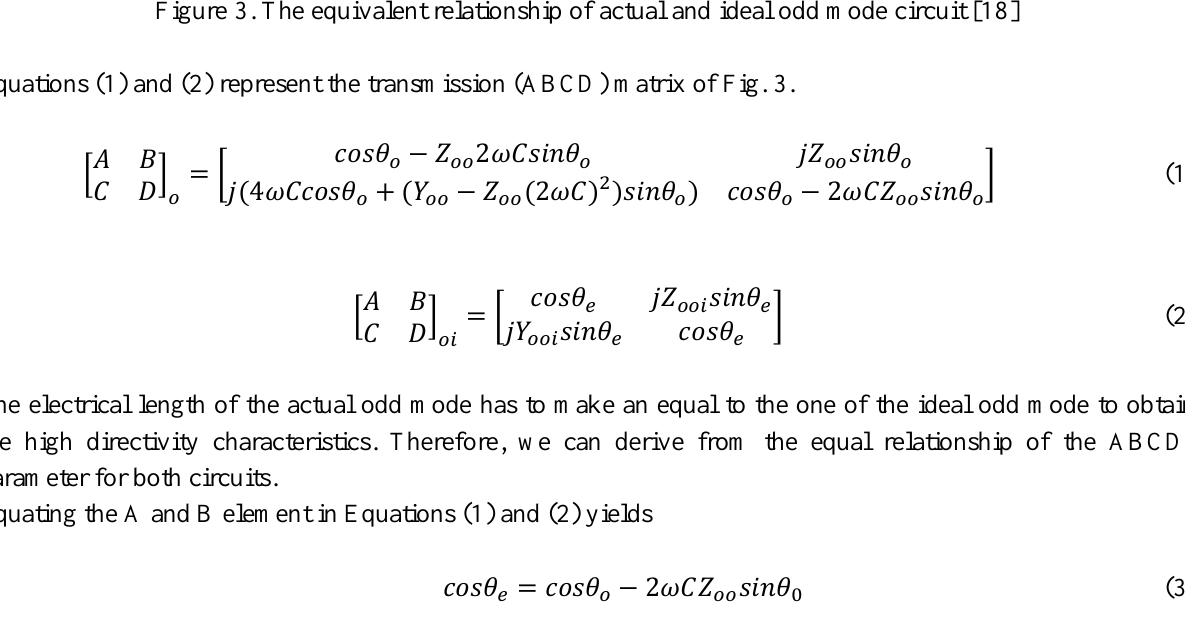
Figure 3. The equivalent relationship of actual and ideal odd mode circuit